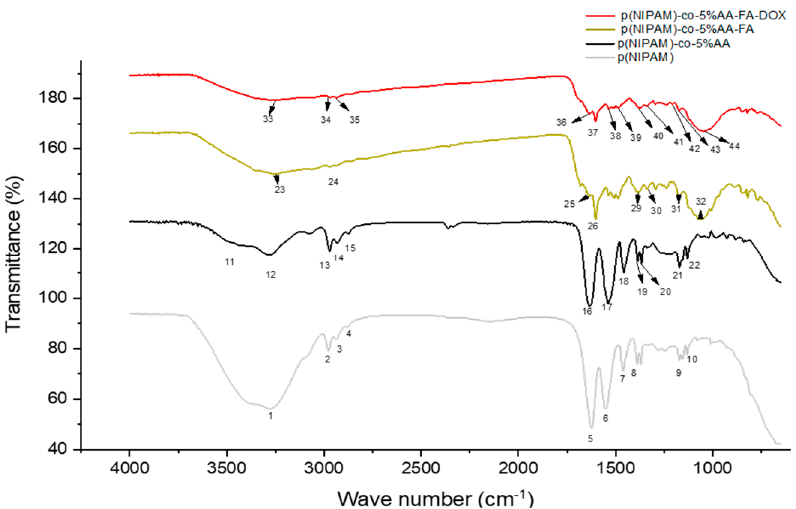
Figure 6. FTIR of p(NIPAM), p(NIPAM)-co-5%AA, p(NIPAM)-co-5%AA-co-FA, and p(NIPAM)-co- 5%AA-co-FA-co-Dox showing the peaks that signify the chemical conjugates of each moiety. p(NIPAM)-co-5%AA-co-FA had additional functional groups due to the presence of FA, such as the aromatic ring in FA, the aryl stretch 1603 cm − 1 and aryl C=C at 1487 cm − 1 and a heterocyclic ring containing secondary amine 1339 cm − 1